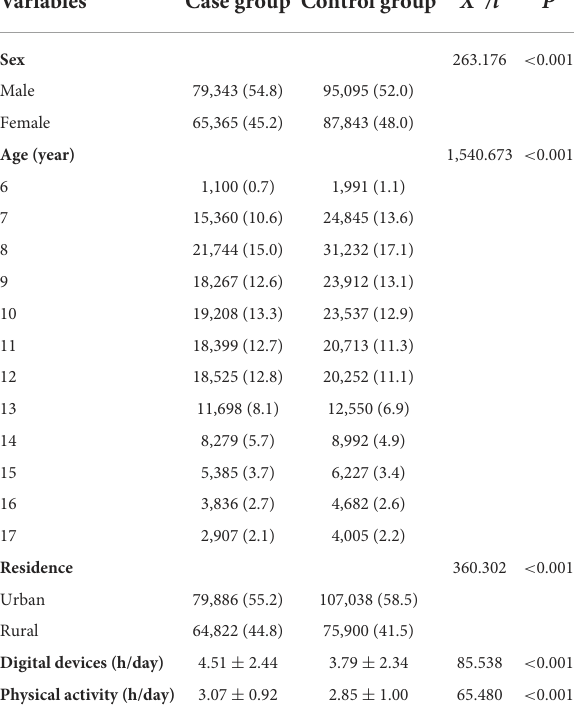
TABLE 2 Logistic regression model of poor visual acuity among children and adolescents.